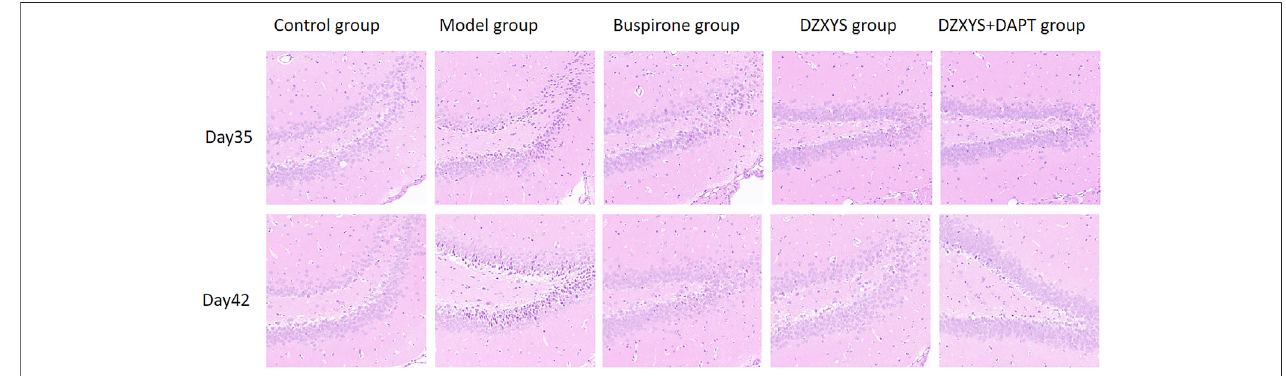
FIGURE 6 | Comparison of HE staining images of neurons in the DG area of the hippocampus in fi ve groups on the 35th and 42nd day after modeling.